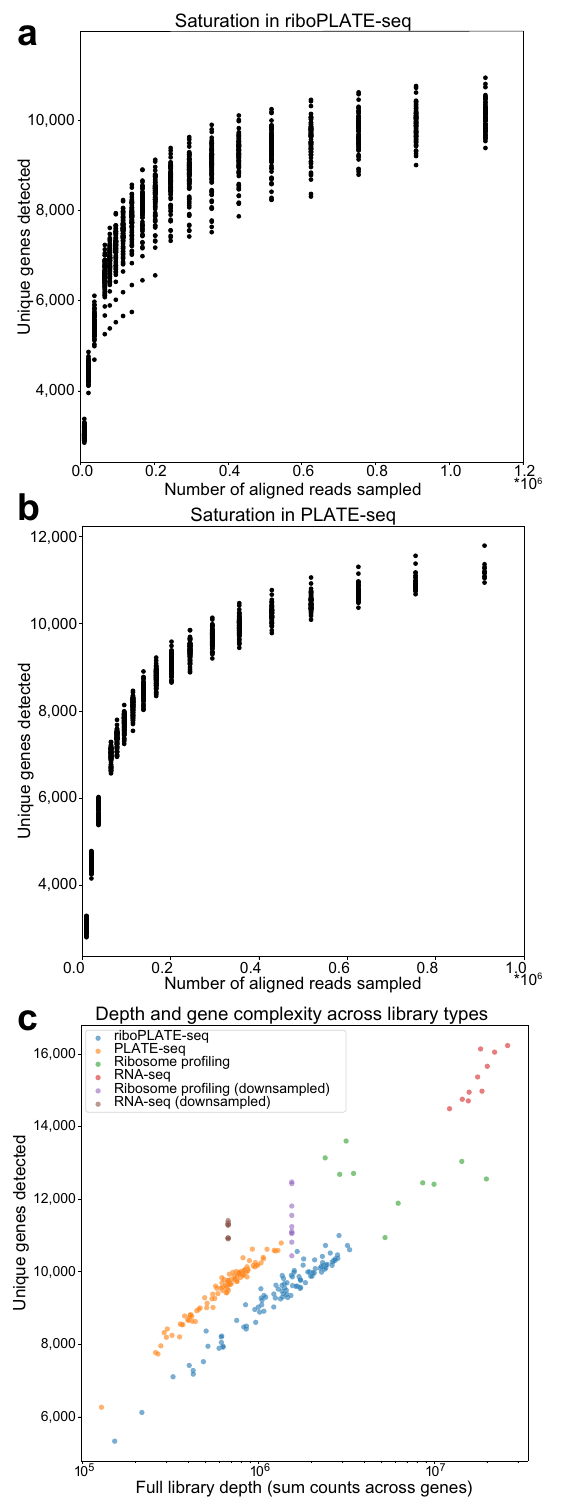
Figure 3. Analysis of riboPLATE-seq library saturation, size, and complexity in TS-543 cells. ( a ), ( b ) Library saturation strip plots for ribosome-associated (riboPLATE-seq) and total RNA (PLATE-seq) libraries in this study. In each, the Y axis shows the number of unique genes detected in each sample at each subsampled read depth on the X axis, excluding libraries smaller than the subsampling depth. With ~ 10–11,000 unique genes detected, riboPLATE-seq and PLATE-seq are comparably saturated. ( c ) Scatter plots emphasizing the relationship between library size and complexity across library types. The Y axis represents the number of unique genes detected within a library; the X axis represents its size in summed gene counts. PLATE-seq and riboPLATE-seq are very similarly distributed, with PLATE-seq generating slightly more complex, smaller libraries than riboPLATE-seq. Ribosome profiling and RNA-seq generate larger, more complex libraries than either riboPLATE- or PLATE-seq, which retain their complexity with ~ 11,000 genes detected when downsampled to the average read depths of riboPLATE- and PLATE-seq,